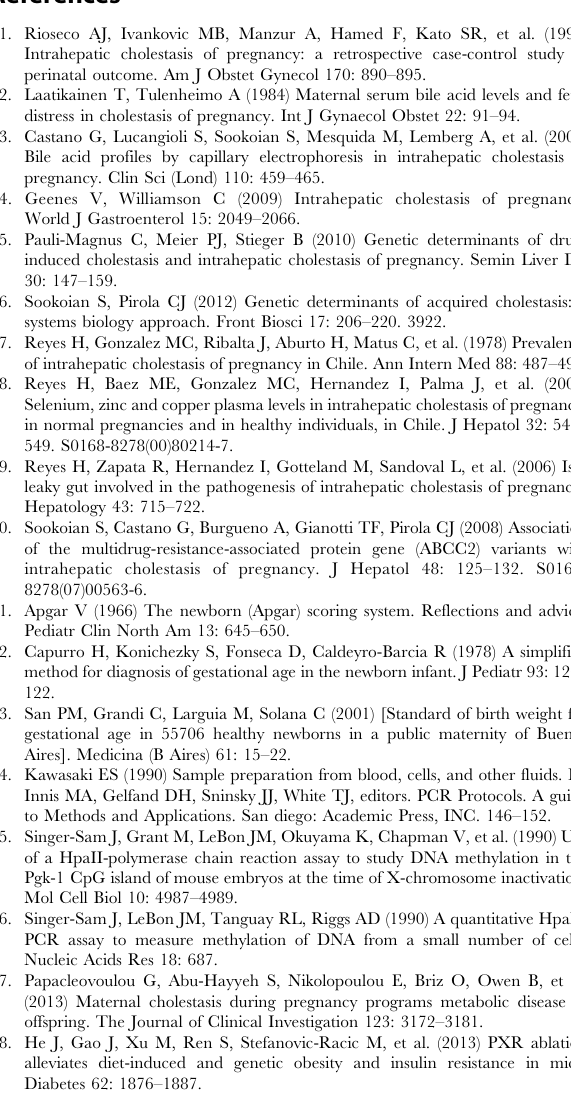
Table S1 Primer Sequences for DNA Methylation promoter detection and messenger gene abundance measurement by